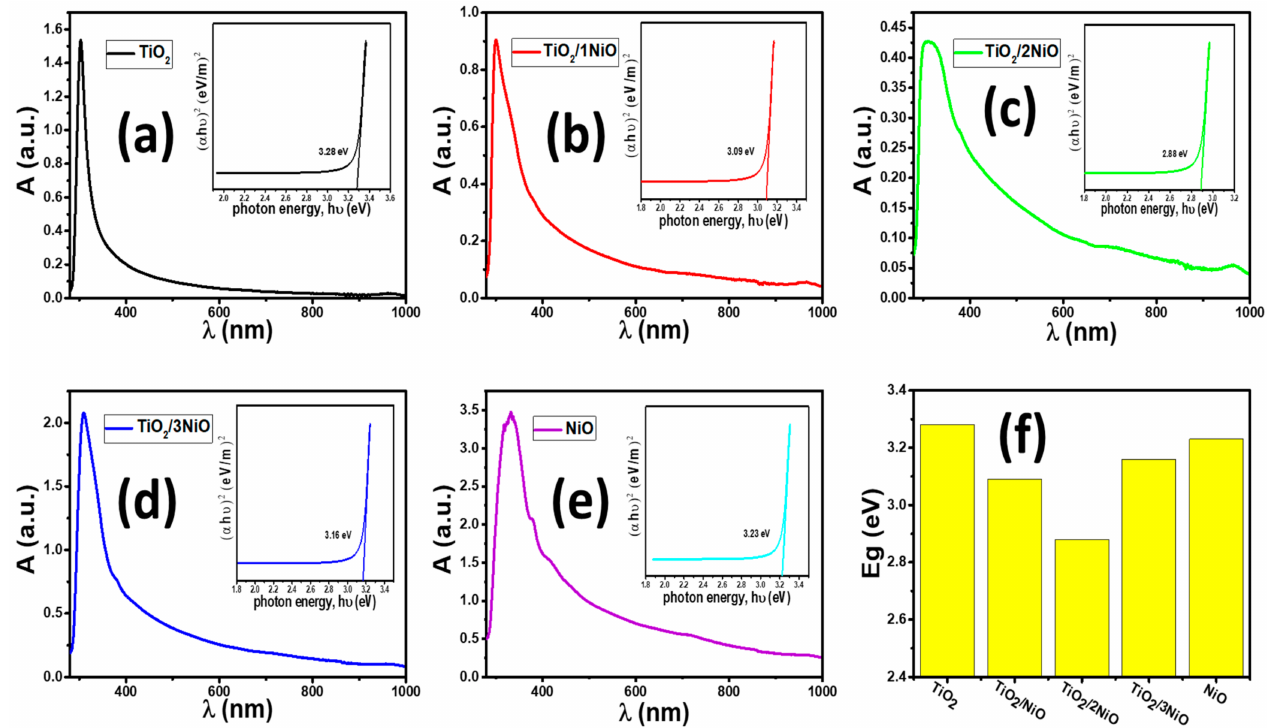
Figure 4. Absorbance spectra with inset figure of Tauc’s plot of ( α h ν ) 2 versus h ν of ( a ) TiO 2 NTs, ( b ) TiO 2 /NiO, ( c ) TiO 2 /2NiO, ( d ) TiO 2 /3NiO, and ( e ) NiO NPs; and ( f ) energy gap of all